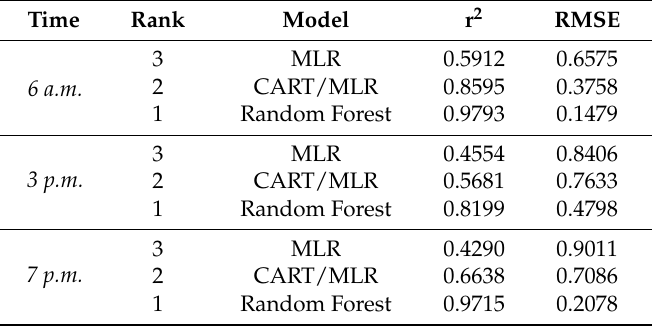
Table 1. Overall Model Performance. Correlation and RMSE values calculated from the 70/30 holdout method for consistency across the three modelling